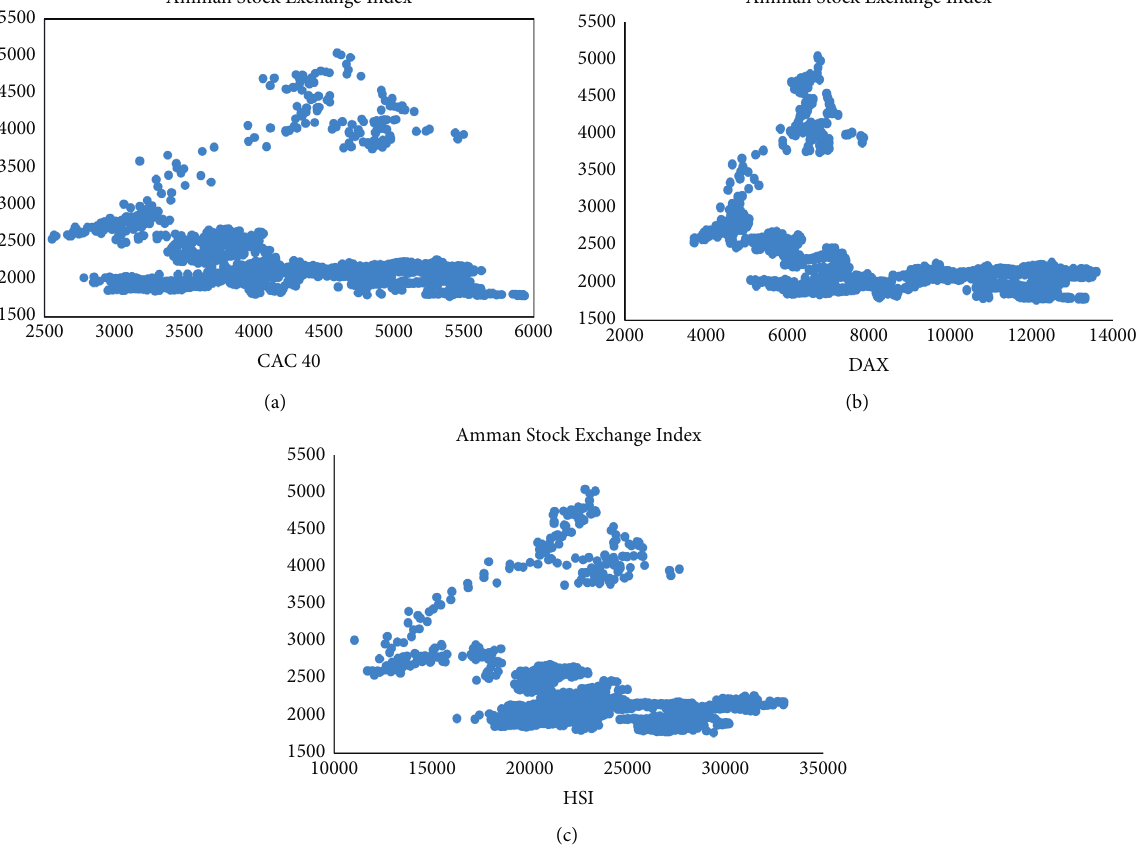
Figure 4: Relationship between ASEI and (a) CAC40, (b) DAX, and (c) HSI stock market indices. Table 7: Analysis of variance of different stepwise linear regression models without using a